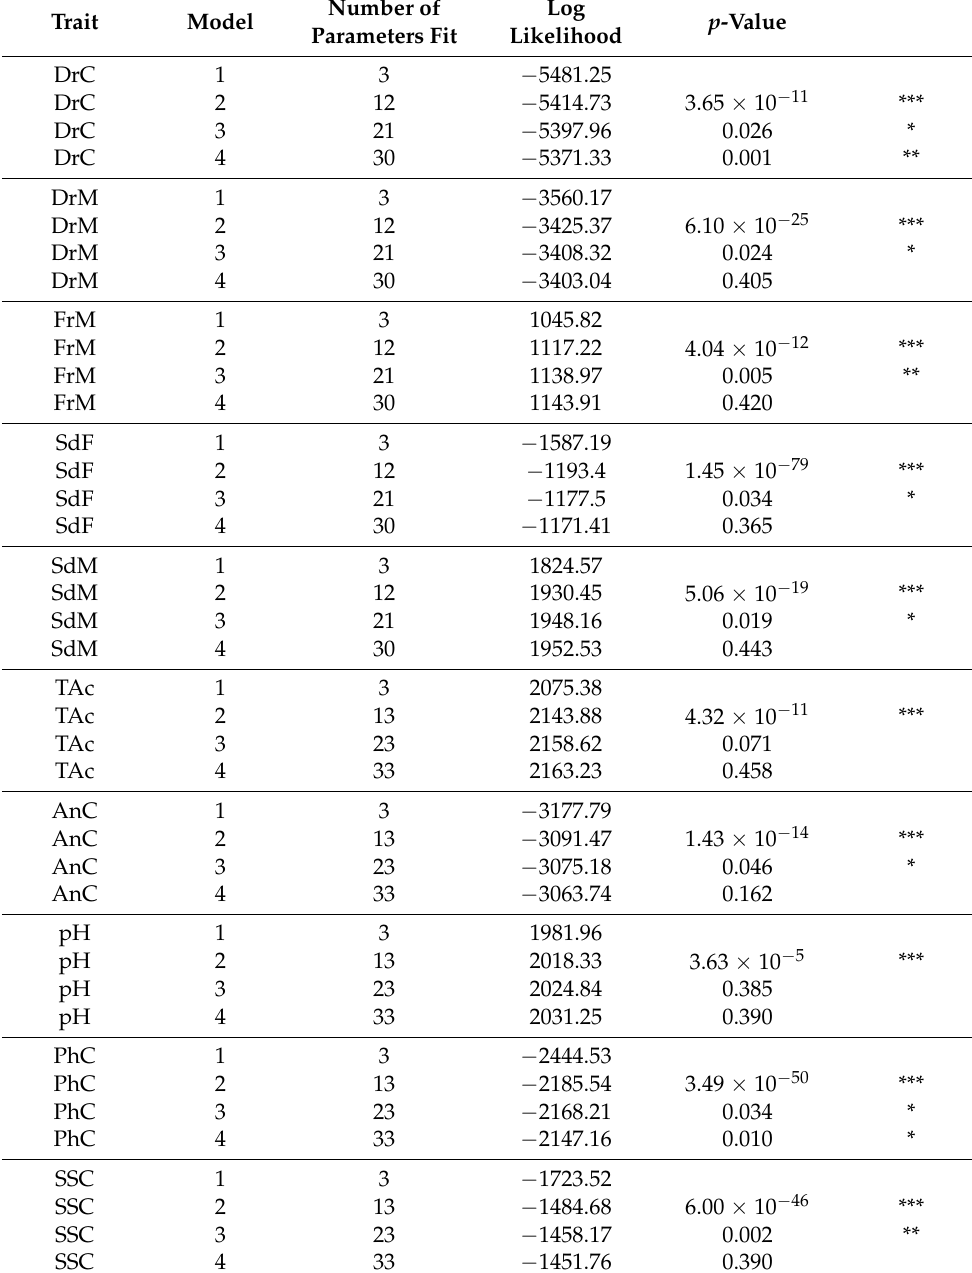
Table 2. Mixed model comparison for black raspberry fruit traits with fixed environmental effects and random additive genomic-by-environment effects (G A × E ). G A × E variance structures were fit as homogeneous with uniform correlation, heterogeneous with uniform correlation, or heterogeneous with non-uniform correlation estimated via factor analysis. Residual variance structures were fit as independent with homogeneous variance or independent with heterogeneous variance. Each model was tested against the previous model using a likelihood ratio test. FrM = fruit mass; SdM = seed mass; DrC = drupelet count; DrM = drupelet mass; SdF = seed fraction; SSC = soluble solid content; TAc = titratable acidity; AnC = anthocyanin content; PhC = phenolics content. Number of Log p Trait Model Parameters Fit Likelihood